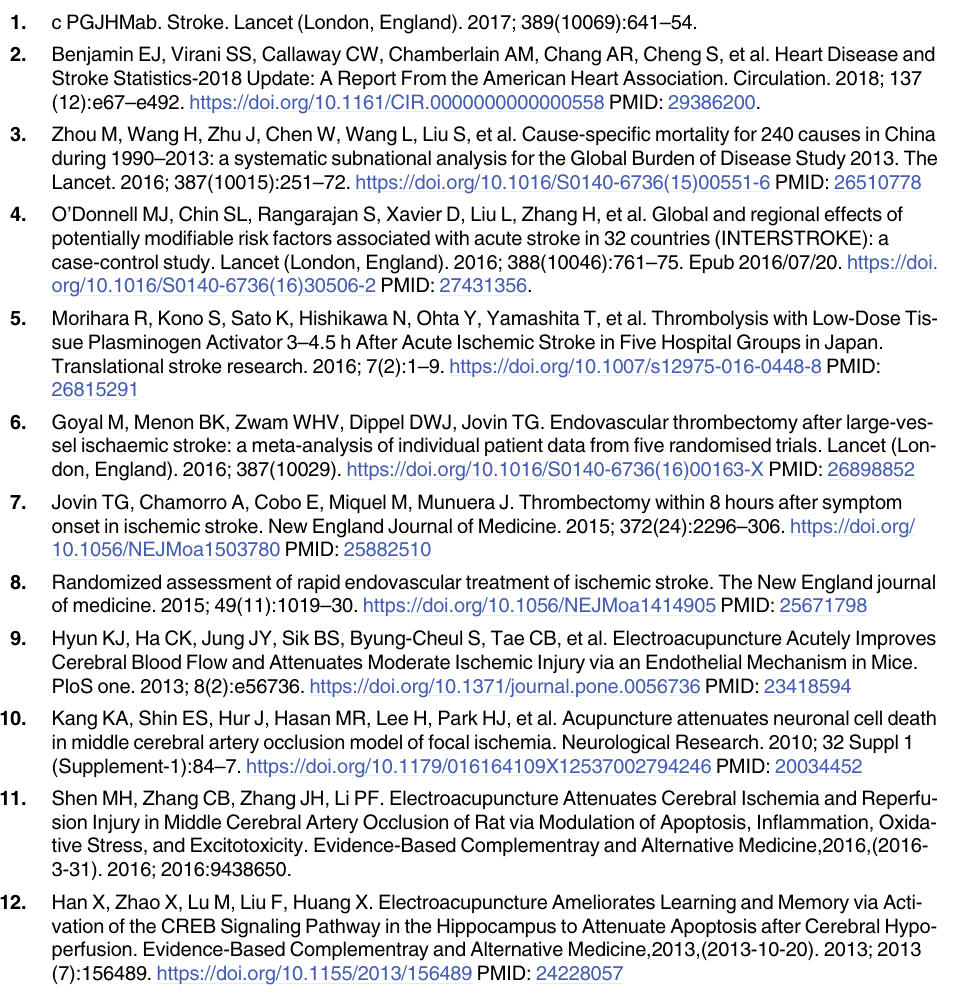
S2 File. Blot results. Original picture of the western blot experiments in the